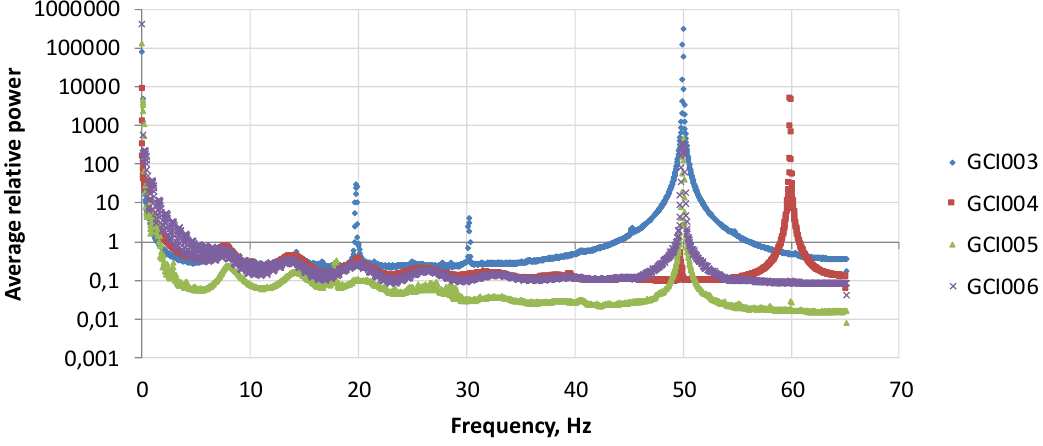
Figure 2. Schumann resonances 24 April 2016 through 30 April 2016 for magnetometers GCI003—Lithuania; GCI004—Canada; GCI005—New Zealand; and GCI006—South Africa.